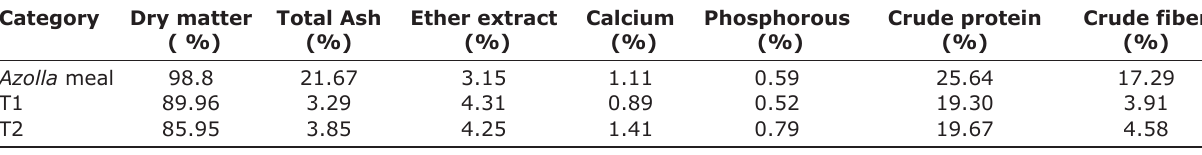
Table-1: Proximate analysis of Azolla meal and turkey feed on dry matter basis.